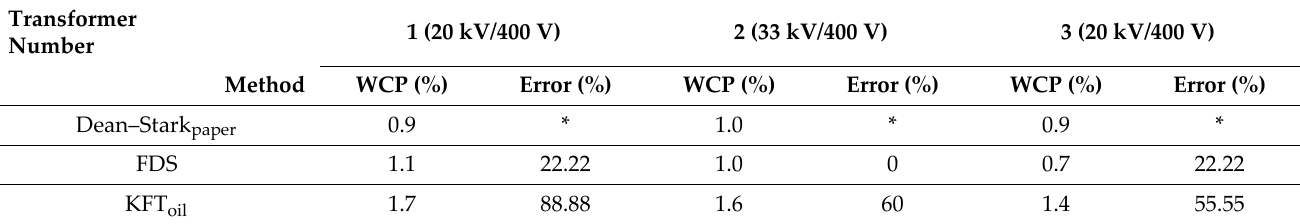
Table 8. Comparison of % error based on different WCP using Dean–Stark paper , KFT oil , and FDS measurement methods.